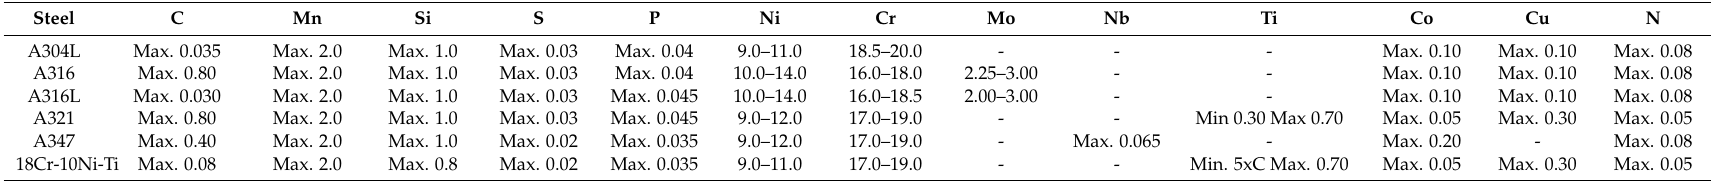
Table 1. The standard element composition of the austenitic stainless steels of reactor core internals (RCI), in wt.